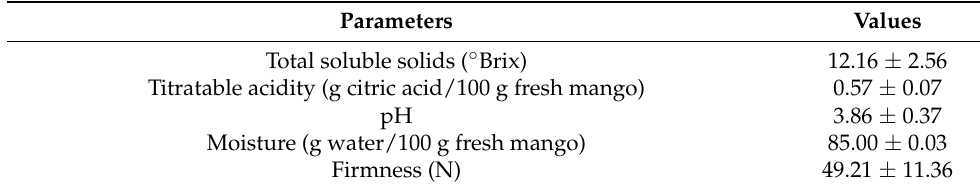
Table 1. Characteristics of mango for